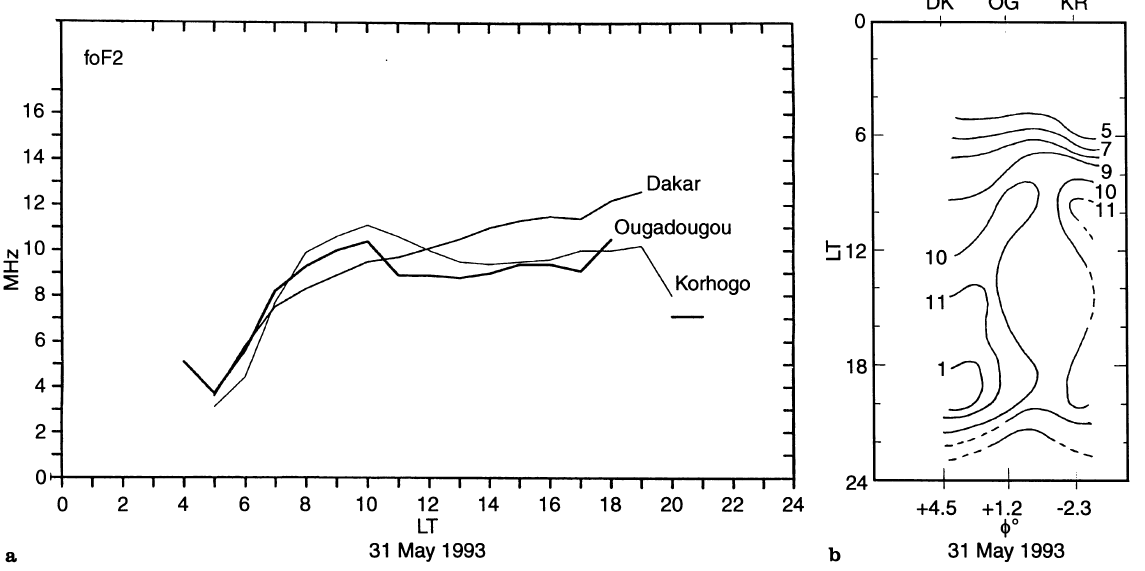
Fig. 1. Peak F2 equatorial ‘‘trough’’ variations, 31 May 1993: a f oF2(UT) curves for the three stations: Dakar, Ouagadougou, Korhogo. b corresponding f oF2 (magnetic latitude, LT) contour